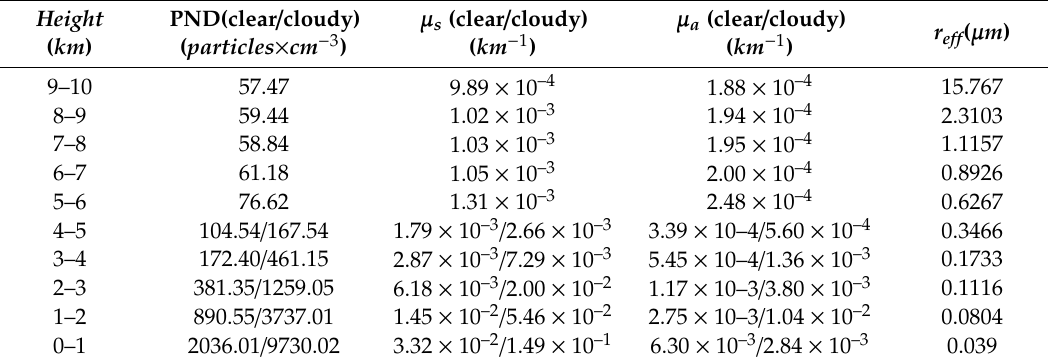
Table 2. The parameters of clear / cloudy